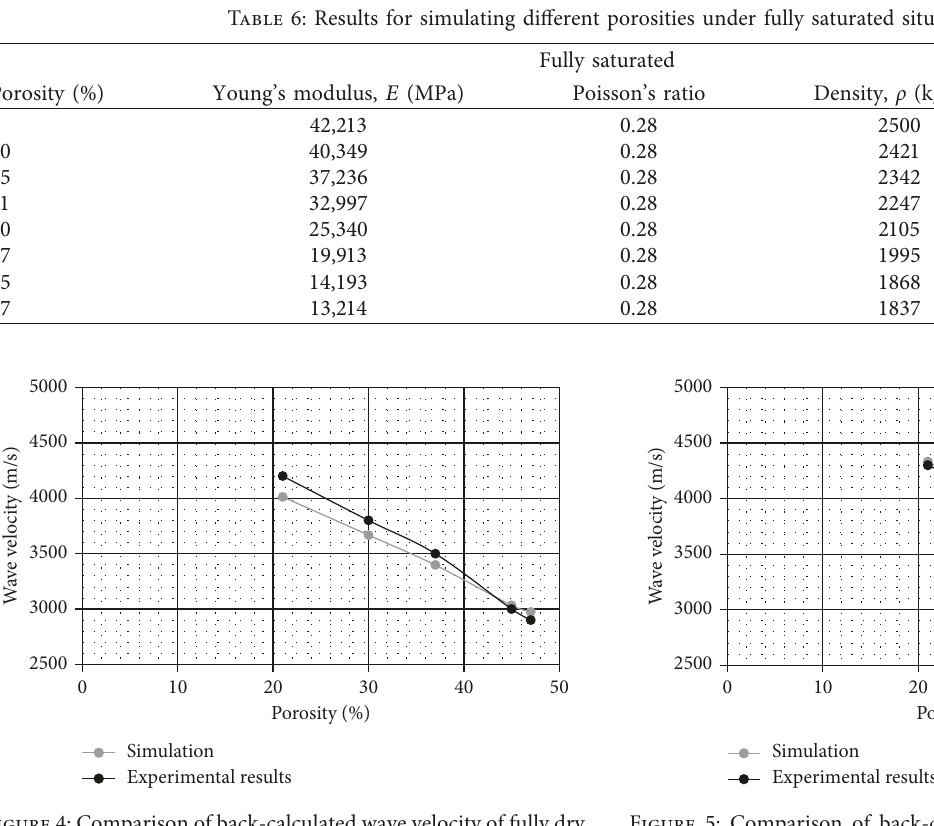
Figure 5: Comparison of back-calculated wave velocity of fully saturated cement paste with those measured (experimental results of Maalej et al.